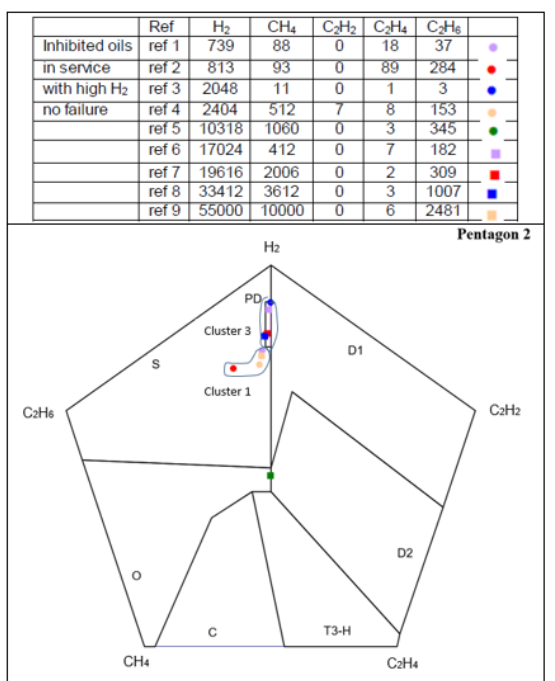
Figure 4. SG of inhibited mineral oils other than oil A in transformers other than from the FKH, in Clusters 1 and 3. Clusters 1 and